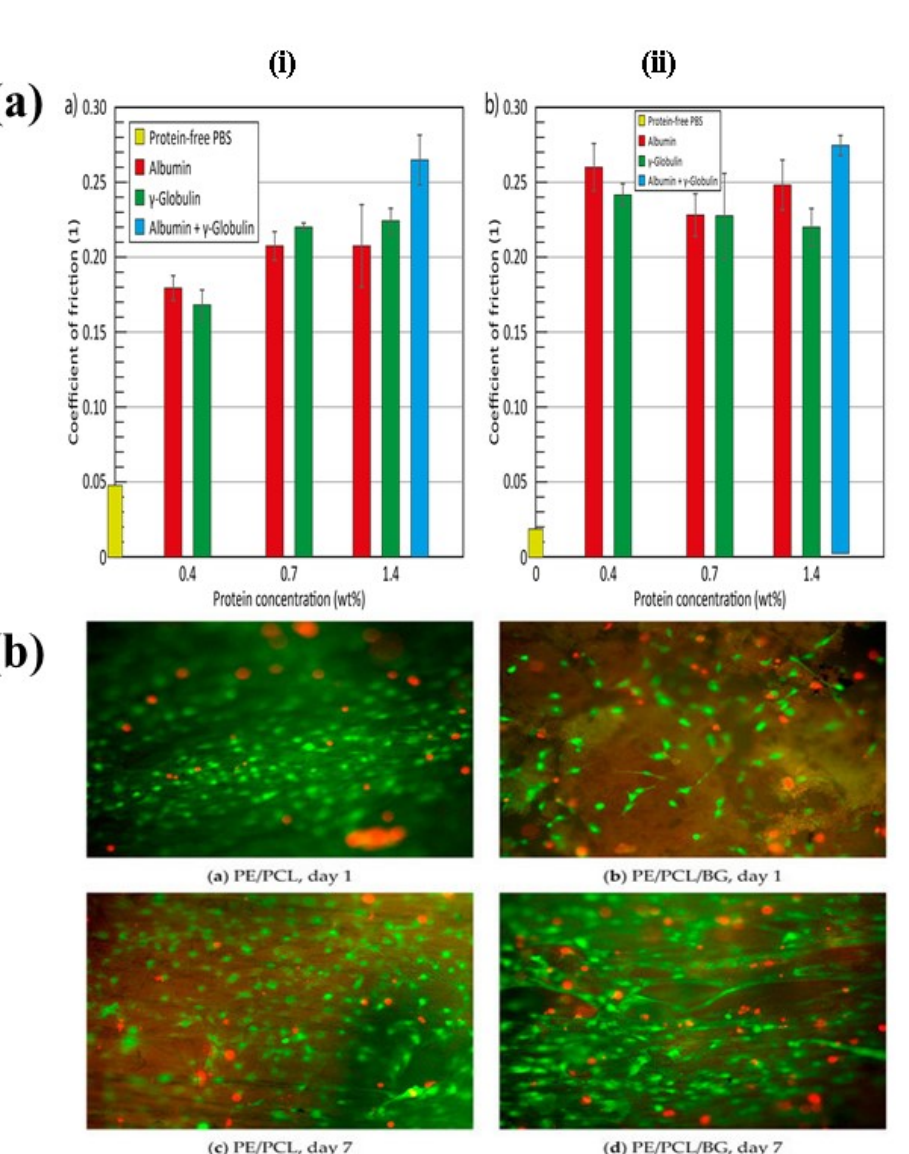
Figure 12. ( a ) The bar graph represents the coefficient of friction vs. protein concentration for all tested protein solutions at different sliding speed: (i) 10 mm and (ii) 50 mm. Reprinted with permission from [153]. ( b ) Live (green) and dead (red) cells on PE/PCL a,c, and PE/PCL/BG composites b,d after one a,b and seven c,d days of culture [154].